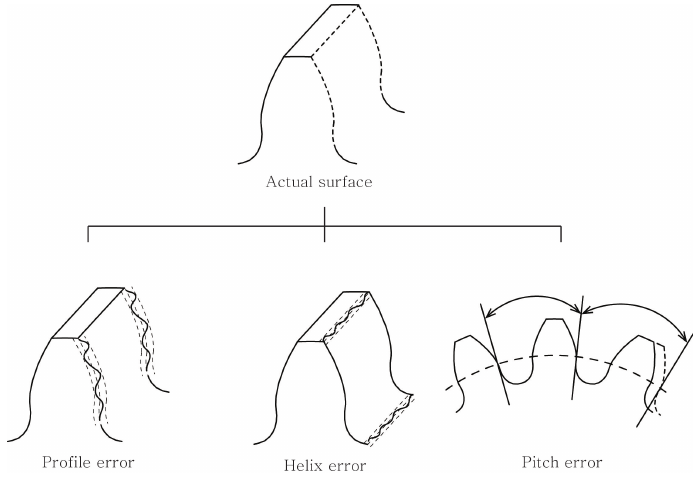
Figure 4. Complex error on tooth